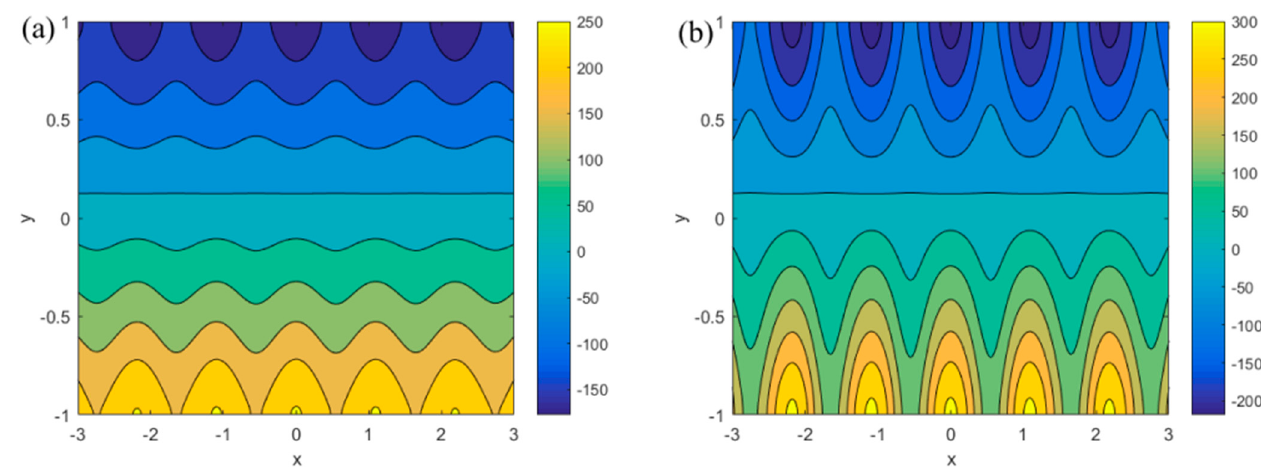
Figure 2. Distributions of streamlines for different α and β ( Ha = 1, κ = 8, δ = 0, u r = 0.6, R = 0.6, m = 5.5, n = 5.8, ξ 1 = 0.15, ξ 2 = 0.18). ( a ) α = 1.5, β = 1.8; ( b ) α = 5.5, β = 5.8.